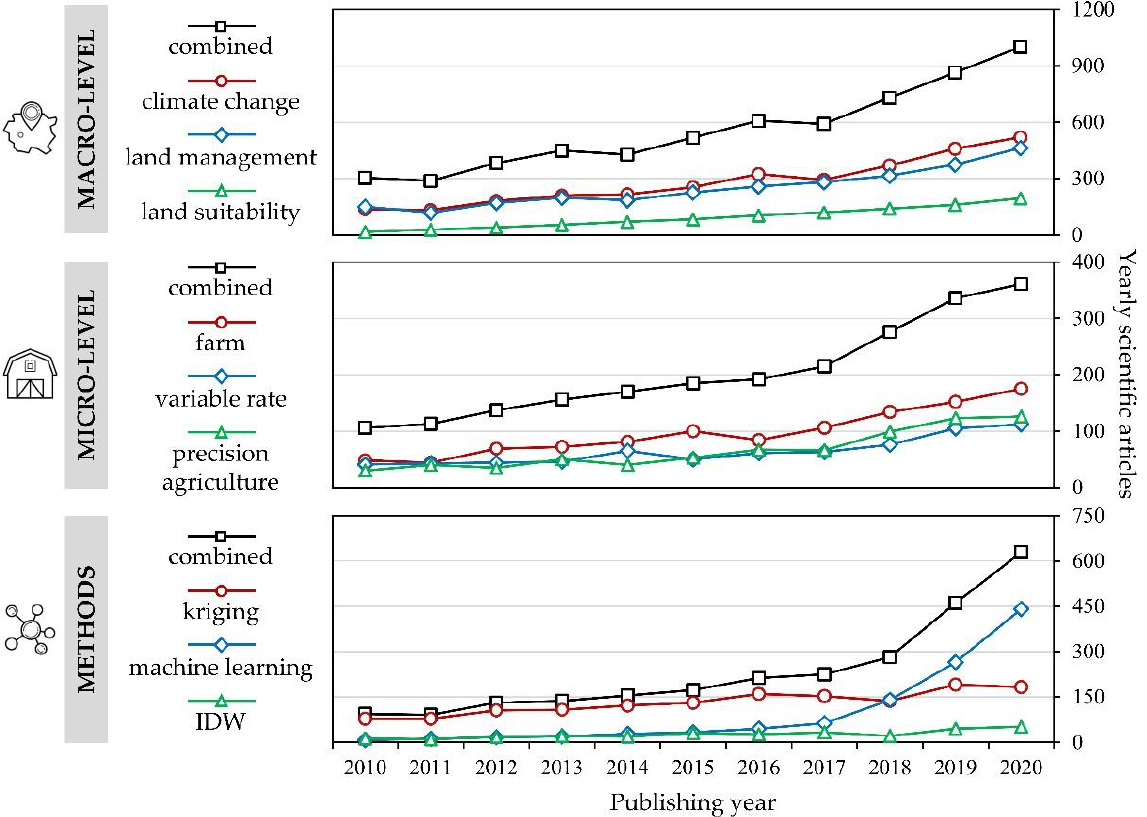
Figure 1. The number of scientific articles indexed in WoSCC from 2010 – 2020, based on the combination of terms “ soil ” , “ interpolation ” , or “ prediction ” , with specific terms listed.